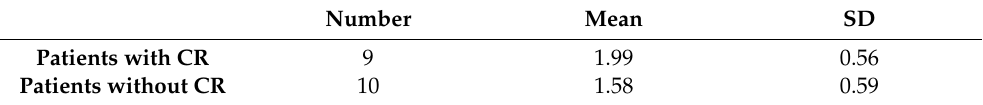
Table 3. Relationship between TDF duration and clinical relapse in the TAF group. Number Patients with